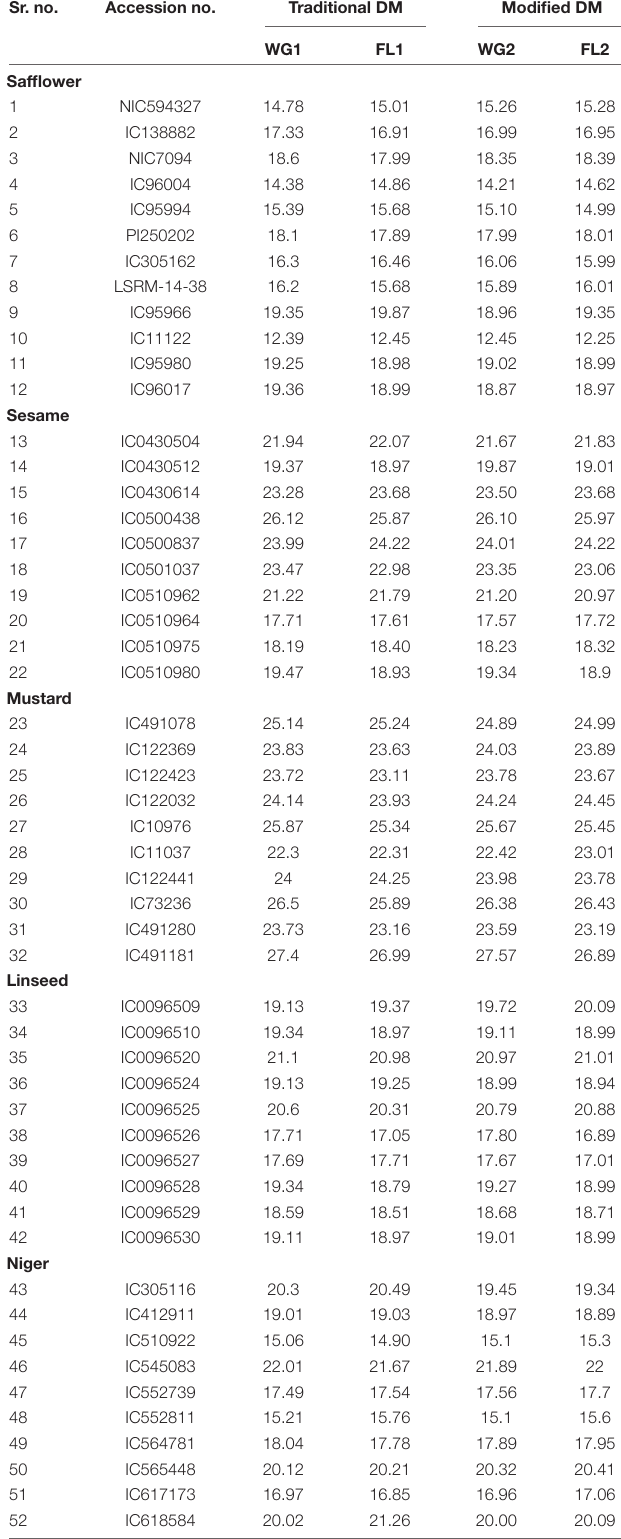
TABLE 1 | Accession number and protein concentration of all the five oilseed crops for flour and whole-grain for both digestion mixtures. Sr.